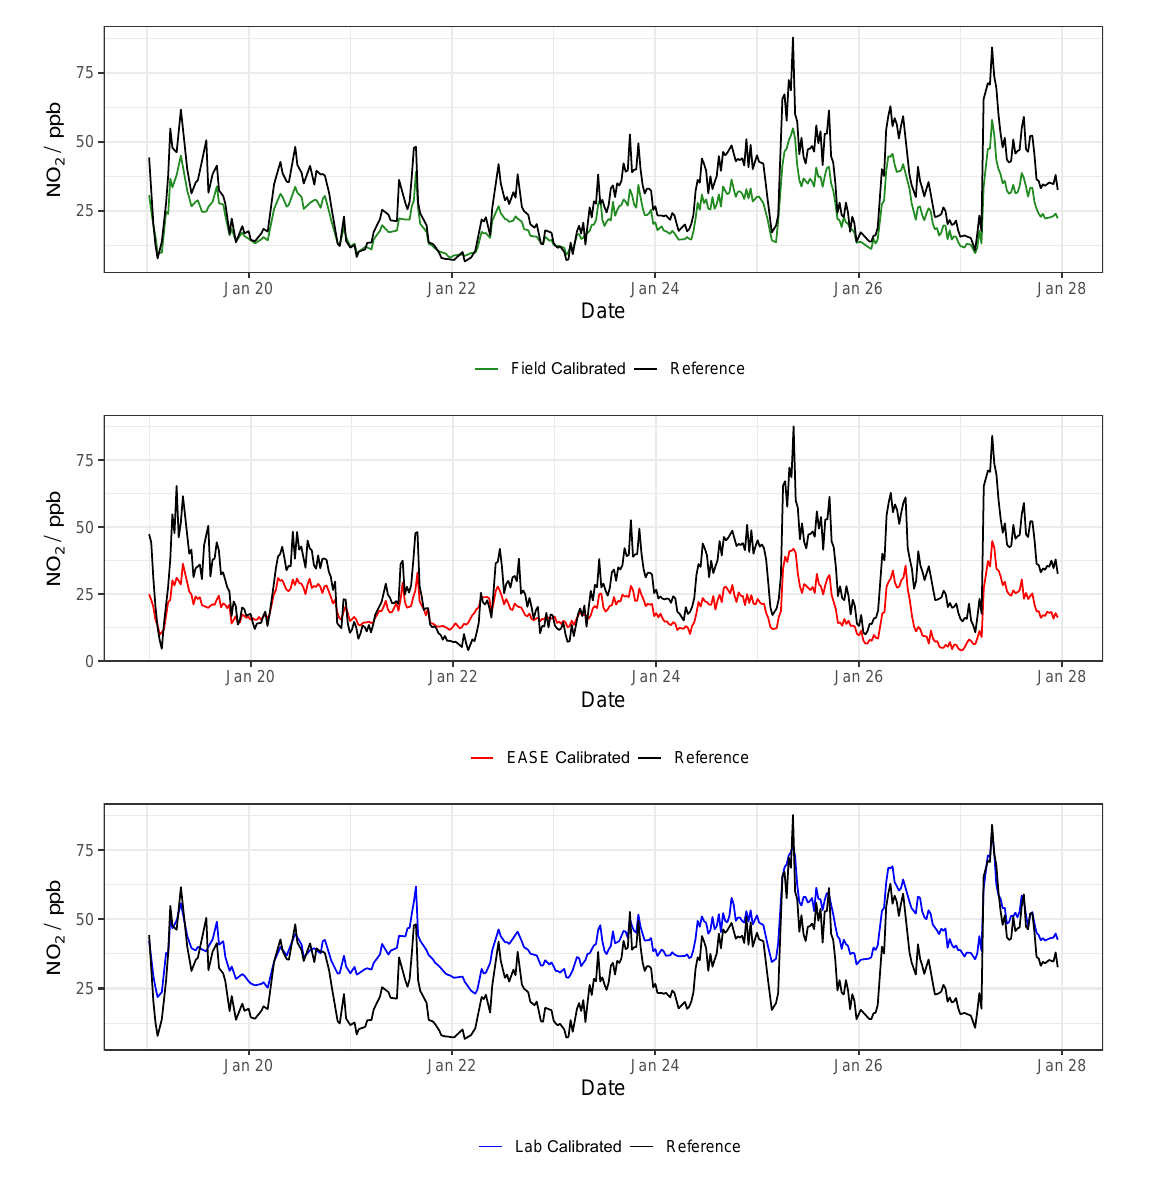
Figure 12. Example NO 2 time-series from a single MOx node during the validation of the different calibration methods, compared with data from the reference instrument. Lab is short for